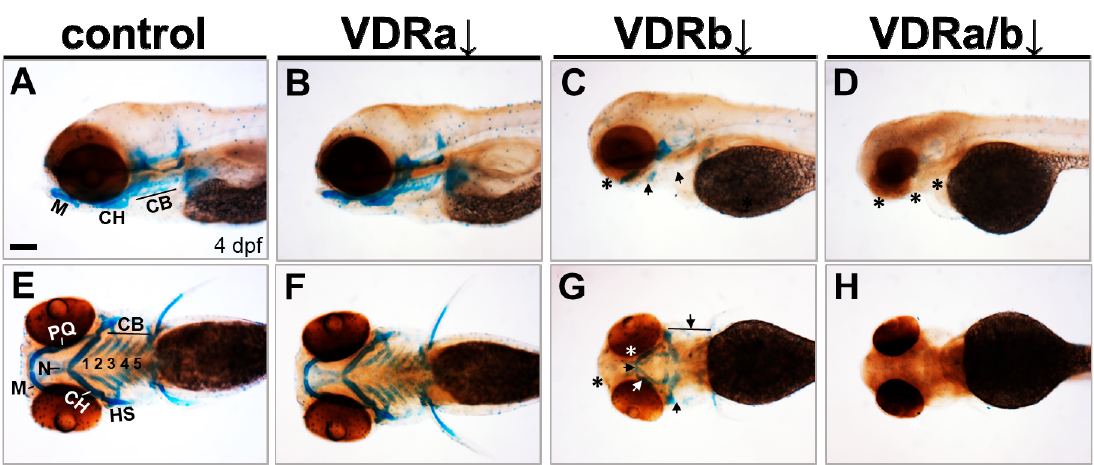
Figure 1. Effects of knockdown of vdr on the craniofacial cartilage development.